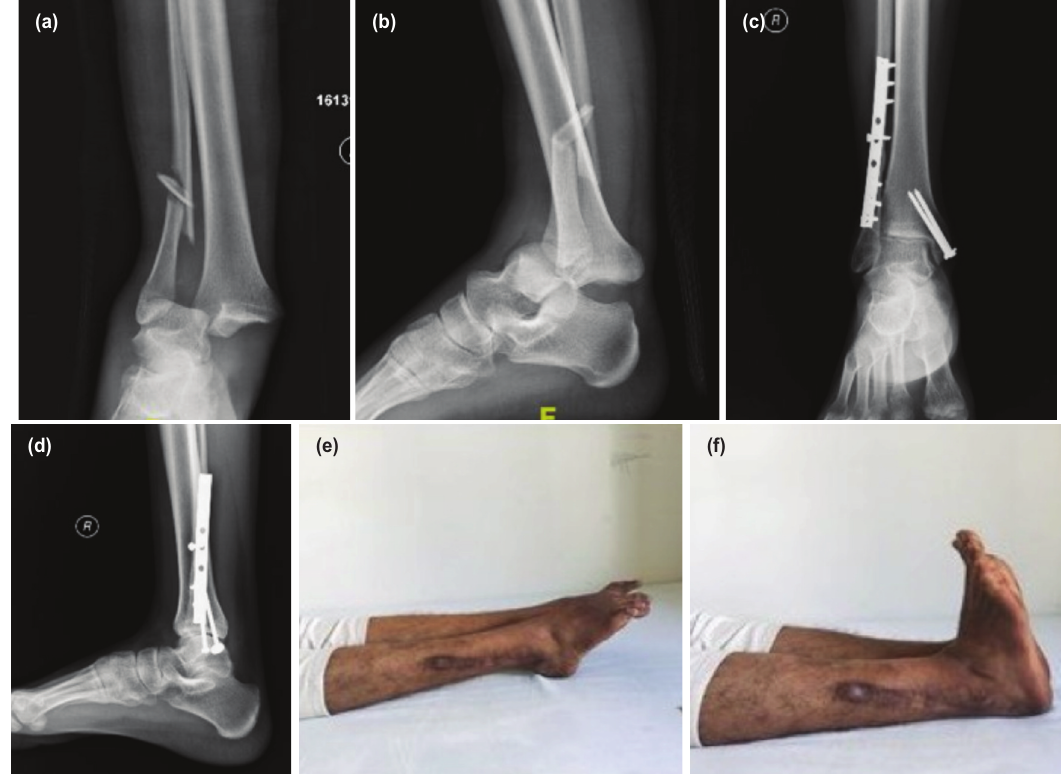
(a, b) Pre-operative radiograph of a 20-year-old male showing ankle fracture dislocation and (c, d) the follow-up radiograph at Fig. 2: the end of one year. (e, f) Shows the clinical ankle range of motion at the final follow-up.